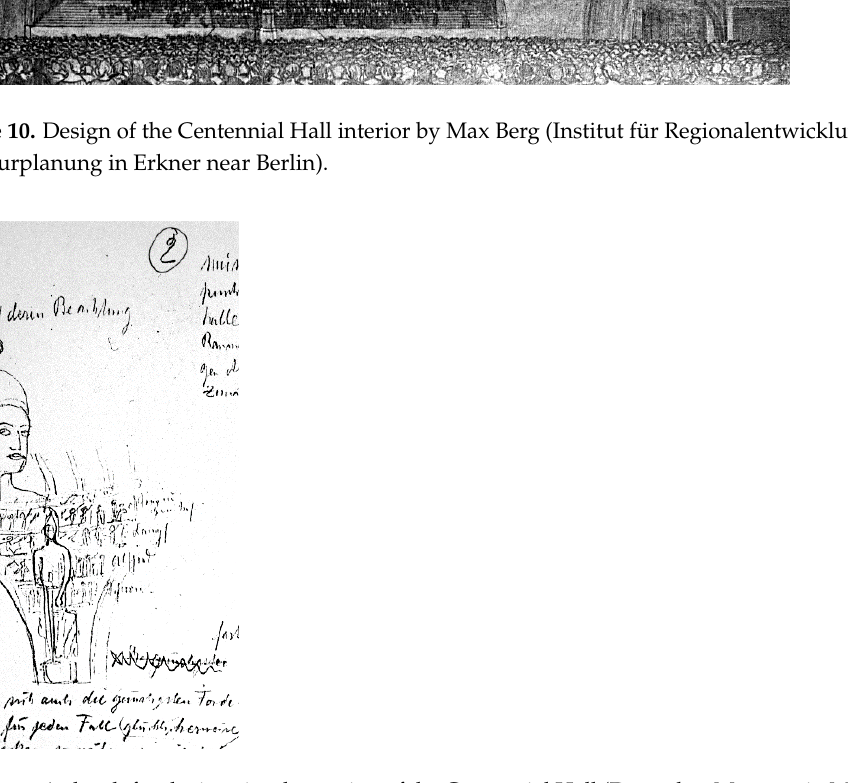
Figure 12. The crematorium designed by Oskar Kokoschka from around November 1914, based on Berg’s designs (Staatlichen Kunstsammlungen Dresden). Assuming that the drawing sketches from the Deutsches Museum concern the crematorium, it can be assumed that Berg initially presented Kokoschka with three preliminary design versions. They were probably intended to help the painter find a suitable artistic and iconographic form for the crematorium frescoes. It was probably for